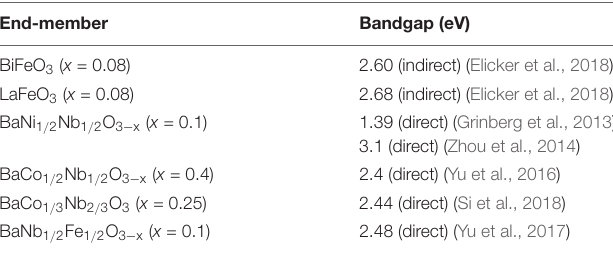
TABLE 5 | Experimental bandgap values for KN-based solid